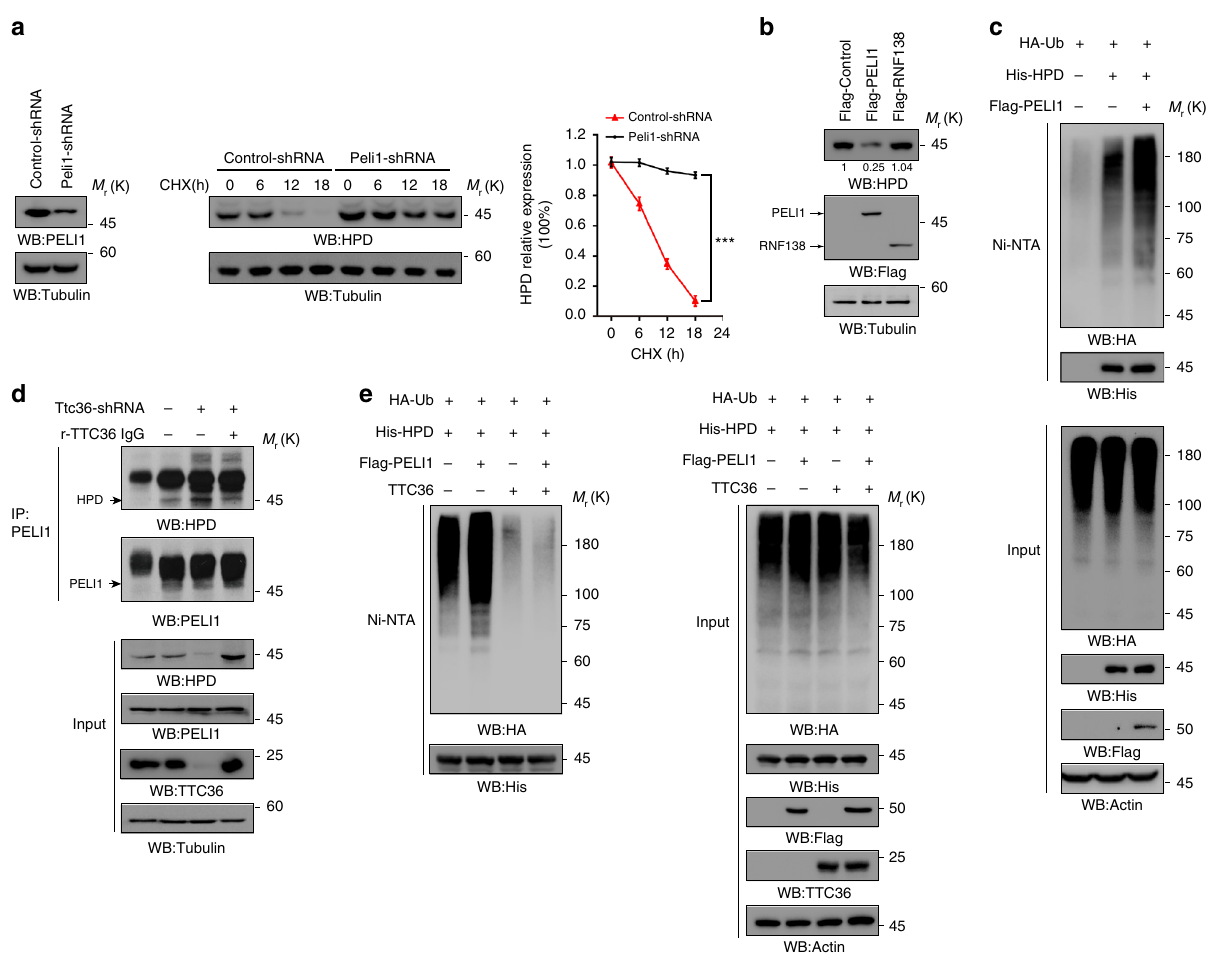
Fig. 2 TTC36 blocks the binding of PELI1 to HPD. Immunoblotting analyses were performed with the indicated antibodies a – e . a LO2 cells expressing a control shRNA or Peli1-shRNA (left); LO2 cells expressing a control shRNA or Peli1-shRNA were treated with 10 μ g mL − 1 cycloheximide for 0, 6, 12, or 18 h (middle); quanti fi cation of HPD levels, respectively, relative to 0 h is shown (right). Data represent the means ± s.d. of three independent experiments. *** P < 0.001, based on the Student ’ s t- test. b Flag-PELI1 or Flag-RNF138 were expressed in LO2 cells. The quanti fi cation numbers represent relative intensity of presented bands. c , e HEK293T cells were transfected with the indicated plasmids and MG-132 (10 μ M) was added to the cells 12 h before they were harvested with a guanidine – HCl-containing buffer. A Ni-NTA pull-down assay was performed. d LO2 stable cells expressing Ttc36 shRNA#1 was stably transfected with a vector expressing RNAi-resistant (r) TTC36. Immunoprecipitation analyses with an anti-PELI1 antibody were TTC36 reduces STK33-mediated HPD T382 phosphorylation .